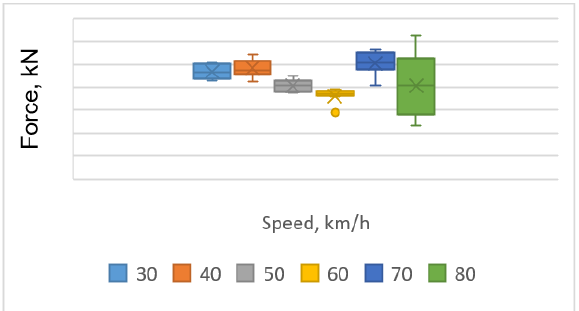
Figure 25. Values of Q M considering the mean vertical forces of loaded goods wagon.